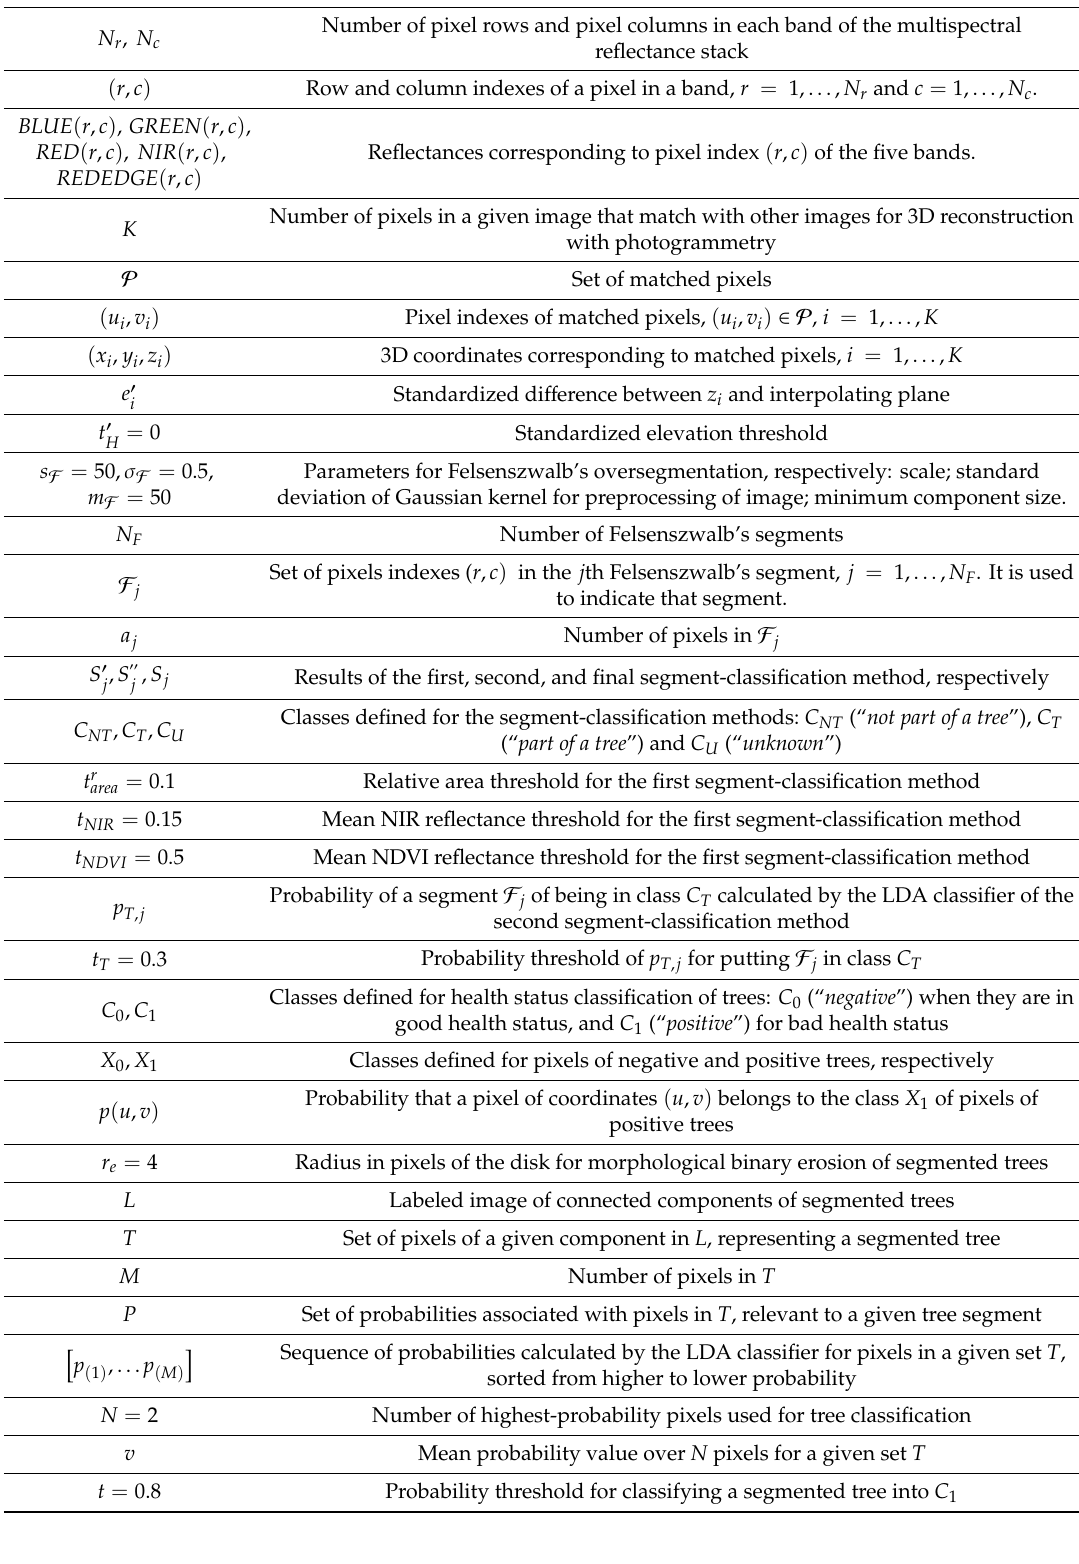
Table 2. Main mathematical symbols. The parameters of the algorithm are in bold. Symbol Description Number of pixel rows and pixel columns in each band of the multispectral reflectance